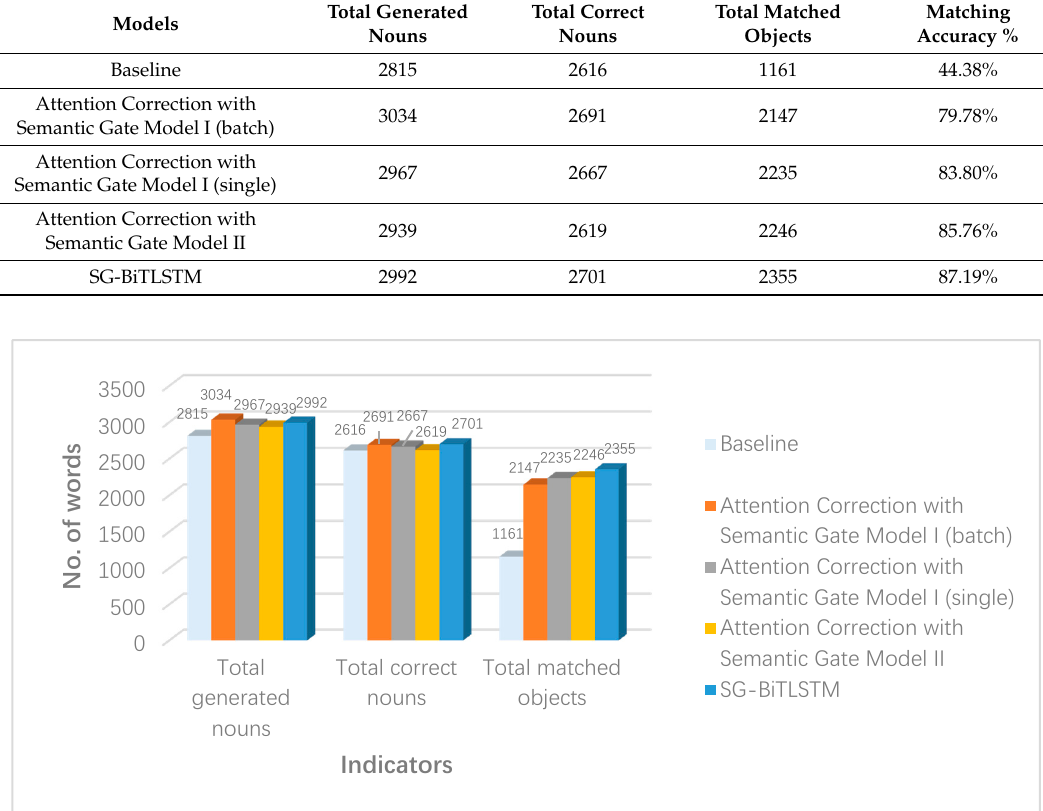
Figure 15. Location accuracy of the models.